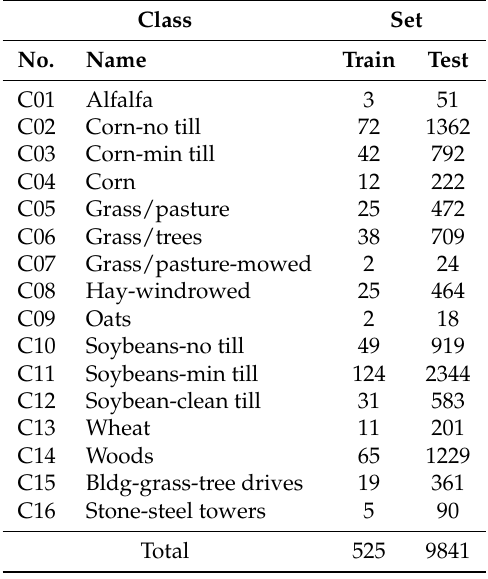
Table 2. Sixteen ground-truth classes in the AVIRIS Indian Pines dataset and the number of training and test pixels used in the